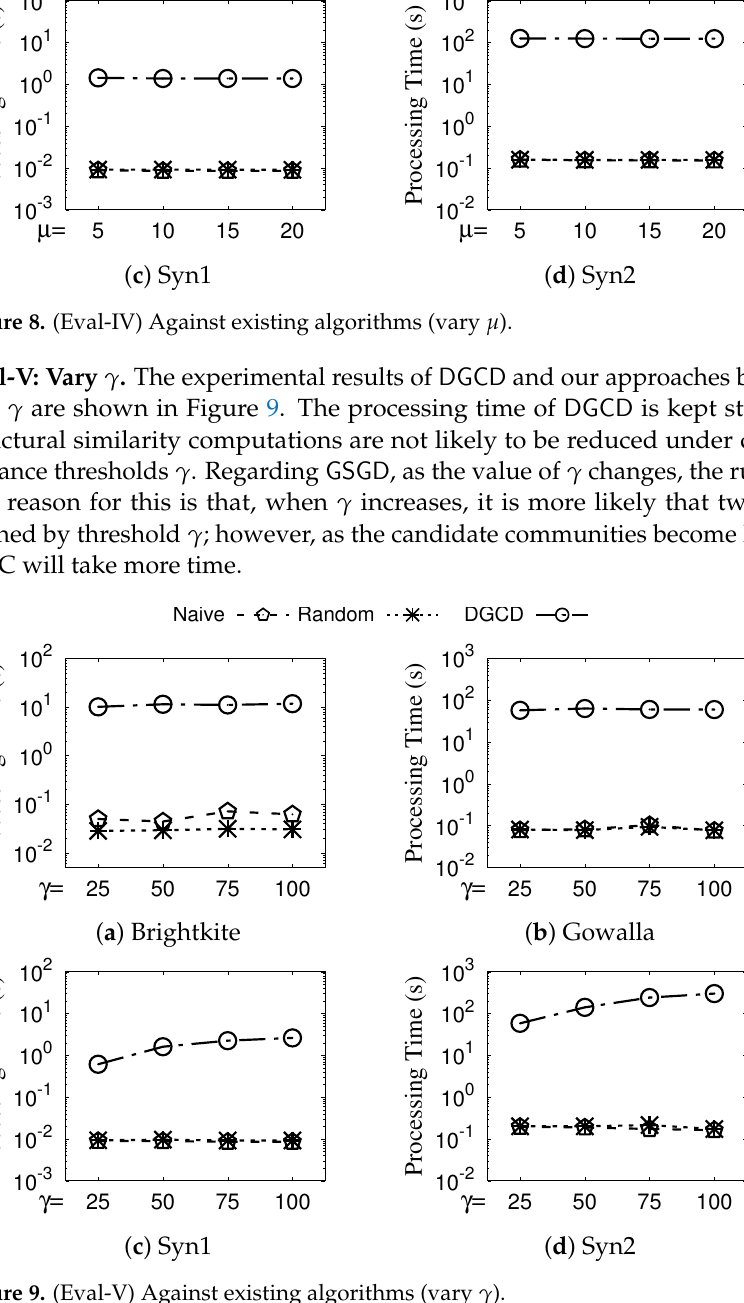
Figure 9. (Eval-V) Against existing algorithms (vary γ